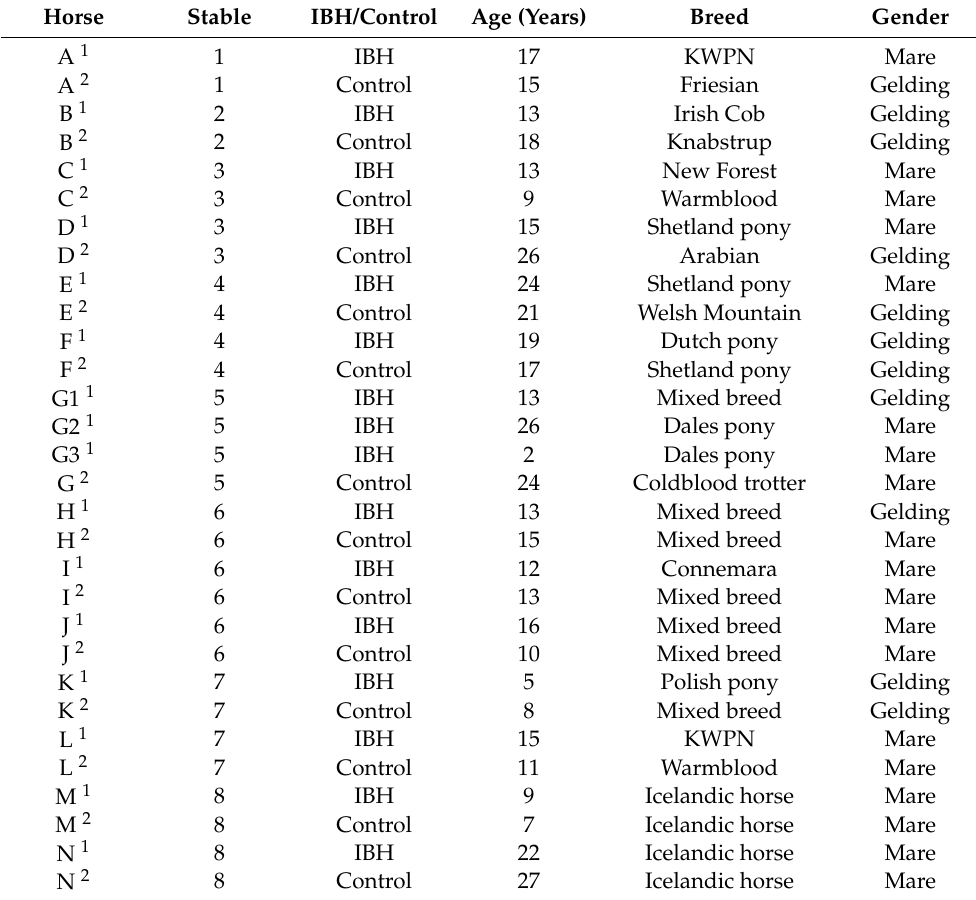
Table 1. Information on age, breed and gender of horses with insect bite hypersensitivity (IBH) and control horses that participated in the study during at least one